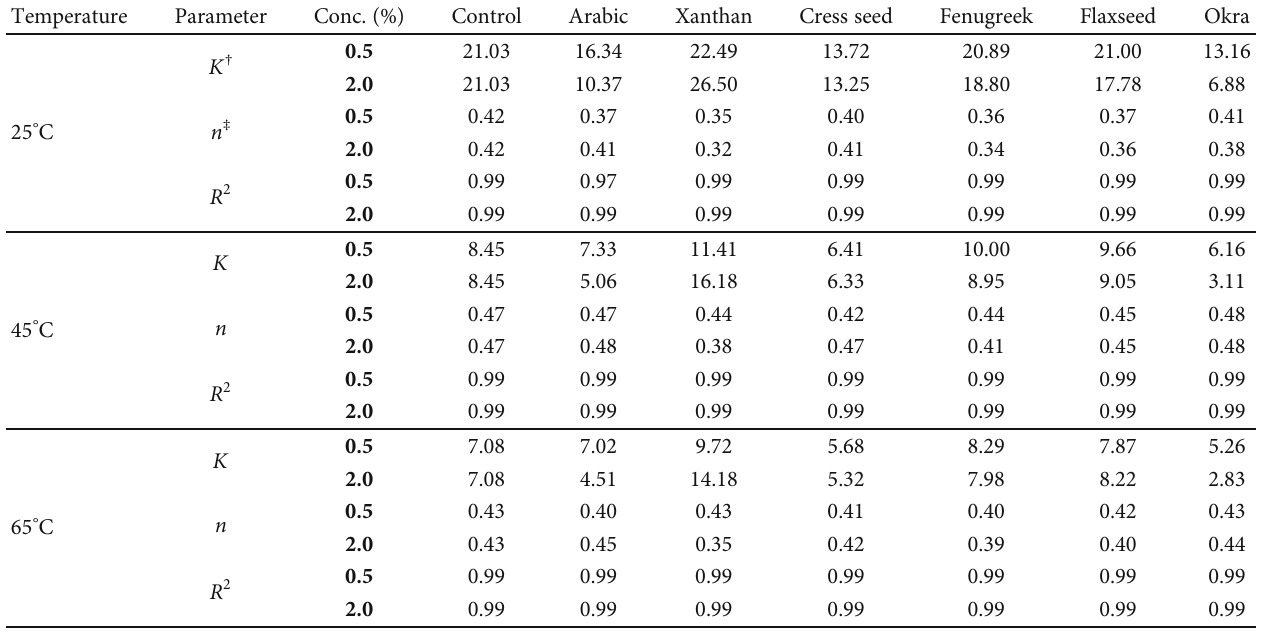
Table 3: E ff ect of gums on consistency coe ffi cient ( K ) and fl ow behavior index ( n ) of sweet potato starch measured at 25, 35, and 45 ° C. Temperature Parameter Conc. (%) Control